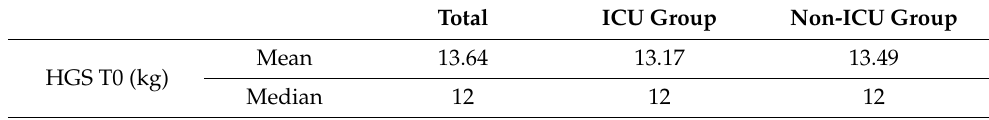
Table 5. Characterization of subjects and Hand Grip Strength (HGS) results from in all evaluation moments (T0; T1;